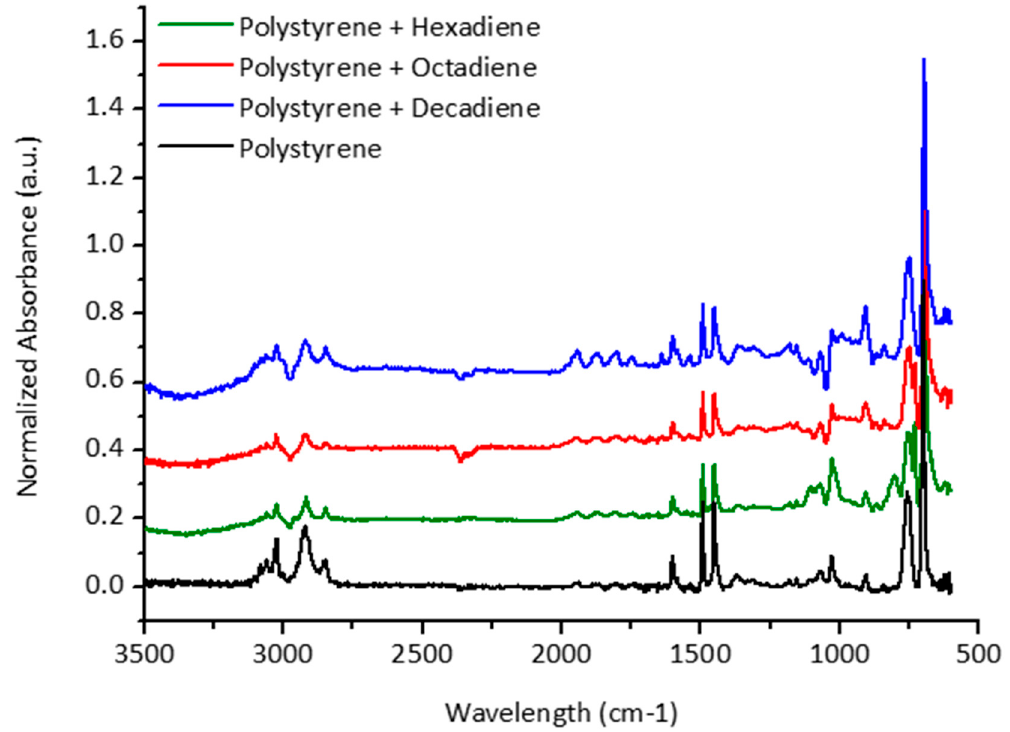
Figure 2. FTIR spectra of pure polystyrene and plasticized polystyrene.